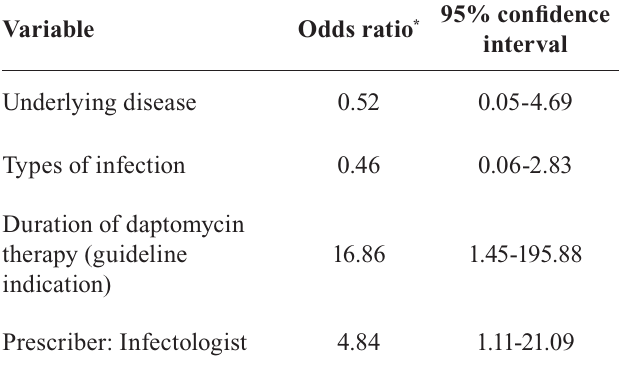
TABLE III - Logistic regression analysis of variables associated with success in the 52 orthopedic patients undergoing therapy with daptomycin. Brazil,